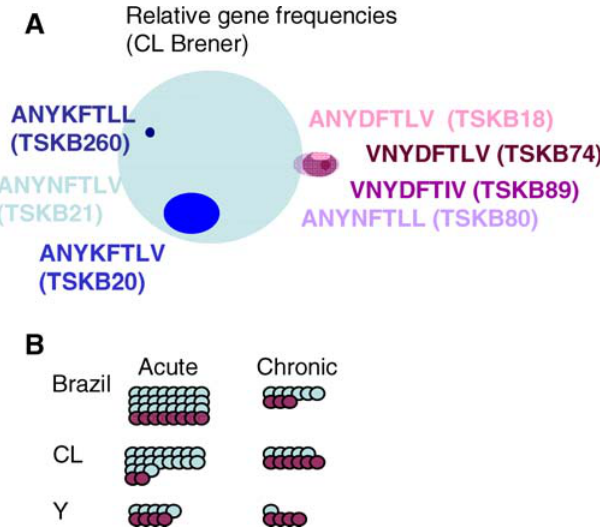
Figure 6. Relative Frequencies of Epitope Occurrences in the Genome and CD8 þ T-Cell Responses (A) Venn diagram representing relative frequencies and overlap of T cells responding to T. cruzi epitopes. The blue shaded circles (left) show the high-abundance overlapping peptides TSKB21 and TSKB20, along with the low-abundance overlapping peptide TSKB260. These peptides are among the most highly represented H-2K b –binding peptides in the proteome and elicit the strongest CD8 þ T-cell response following infection with Brazil strain T. cruzi, as shown in (B). The smaller purple shaded circles (right) show the lower-abundance epitopes TSKB18, TSKB74, TSKB80, and TSKB89, which are recognized by T-cell populations that overlap minimally with TSKB20/21/260-specific T cells. (B) Relative frequencies of CD8 þ T cells recognizing the TSKB20 (blue) and TSKB18 (purple) families of peptides in the acute (left) and chronic (right) phase of T. cruzi infection in mice infected with three different strains. While there are strain-dependent differences in the magnitude of the TSKB20-specific T-cell responses, these responses all follow a similar pattern of expansion and contraction during acute infection, which may be explained simply by strain-dependent differences in the rates of parasite replication and/or expression levels of TSKB20. However, T-cell responses to TSKB18 vary remarkably in both their magnitude and kinetics following infection with the various strains. Sustained expansion of TSKB18-specific T cells following infection with CL or Y strains results in different hierarchies of Ag-specific CD8 þ T cells in chronic infection with the three different strains (right). DOI: